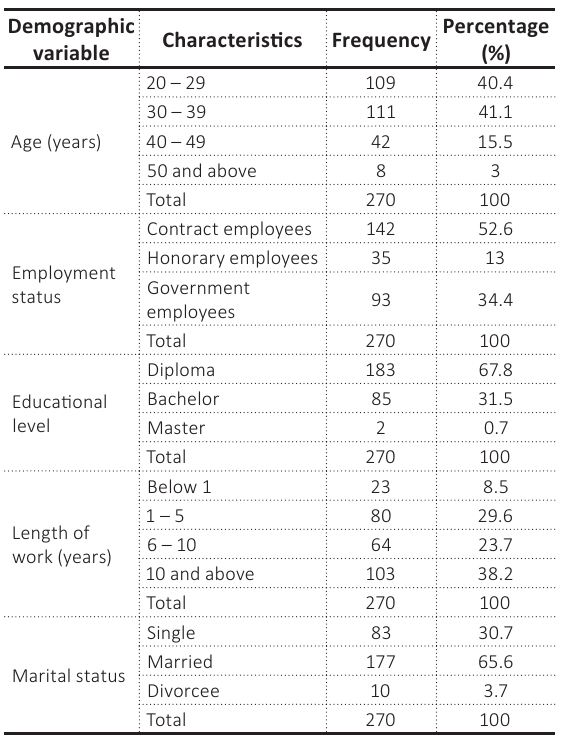
Table 1. Characteristics of respondents